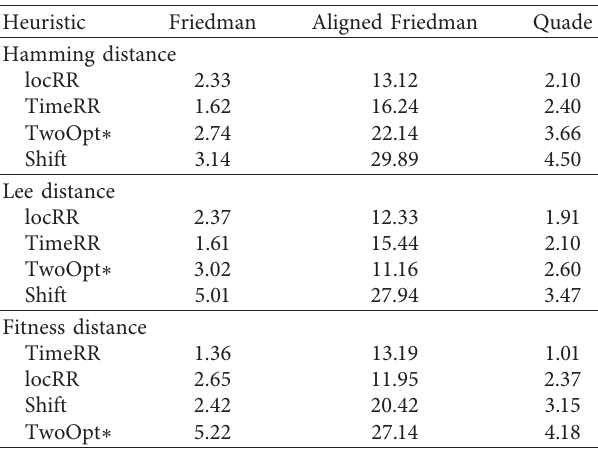
Table 4: Ranking of the vehicle routing heuristics.